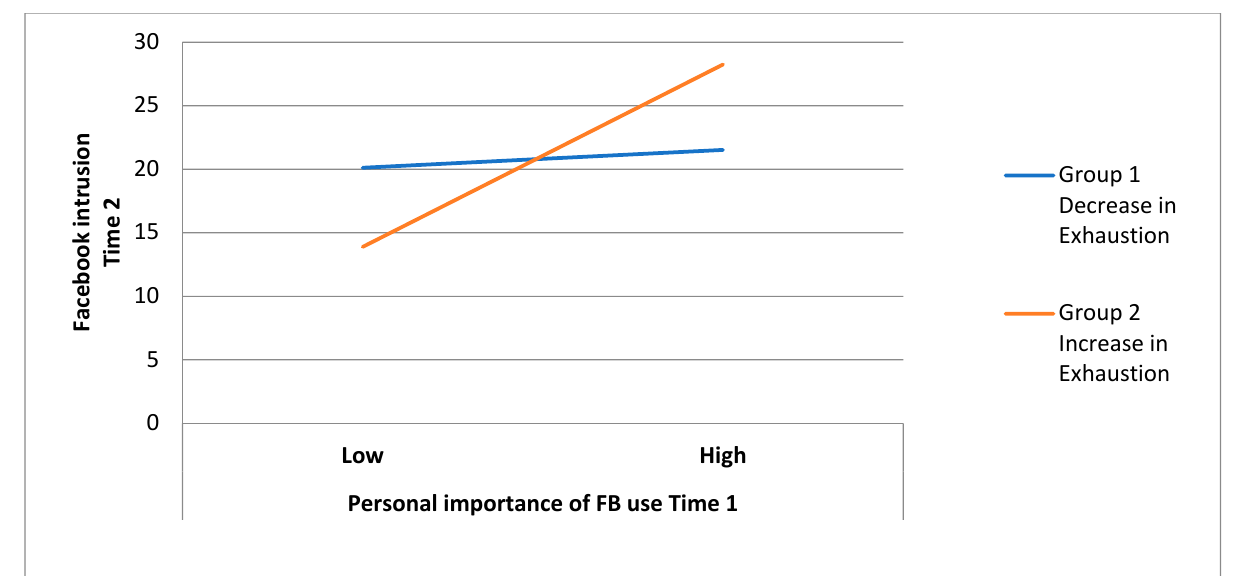
Figure 2. The effects of changes in exhaustion on the association between time 1 personal importance of FB use and time 2 FB intrusion.